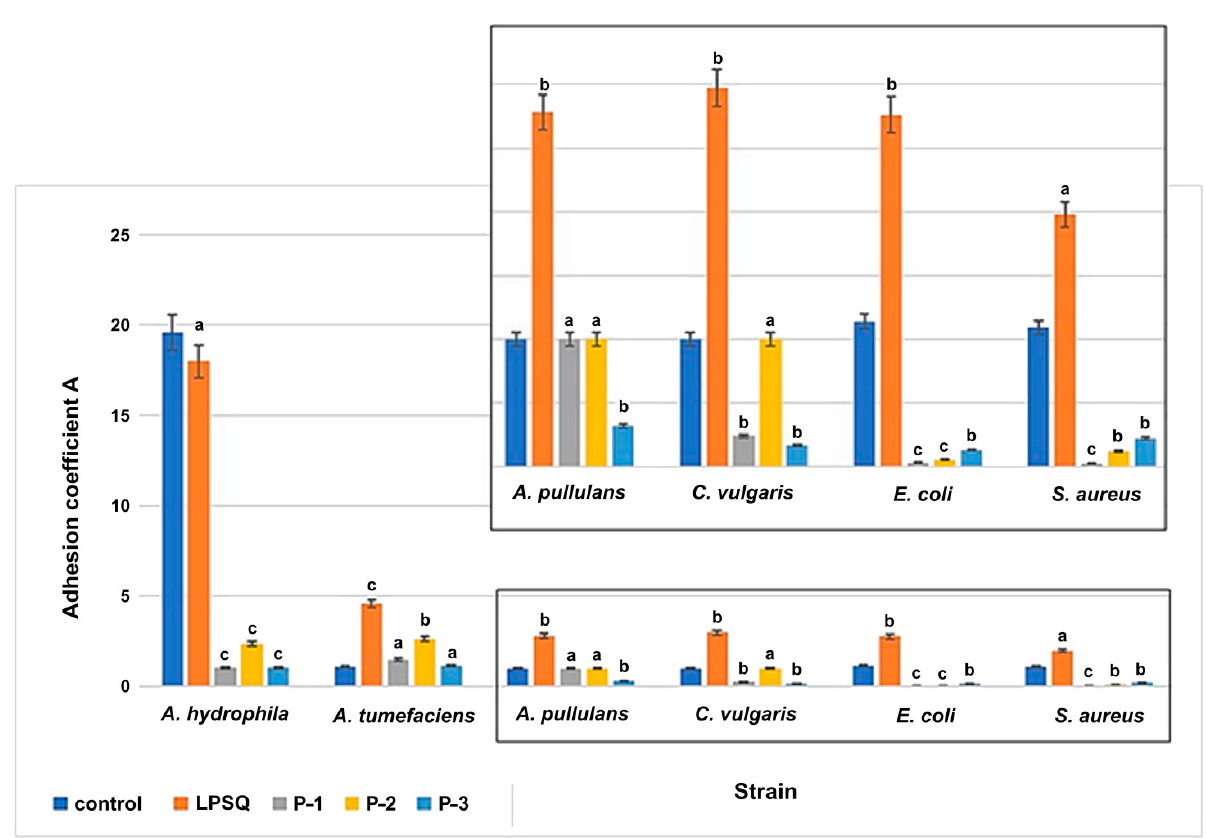
Figure 3. Adhesion coefficient (A) for microbial strains and polysiloxanes functionalized with reactive side groups and a model hydrophobic silicone (LPSQ). The results were compared to those for the control glass carriers. Values with letters show statistically significant differences: a, p ≥ 0.05; b, 0.005 < p < 0.05; c, p < 0.005.